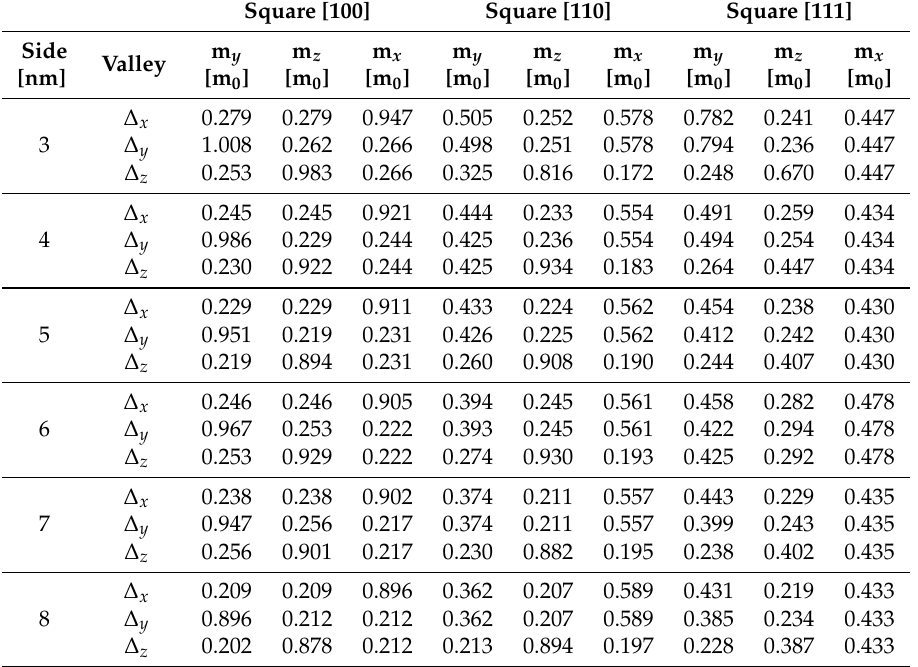
Table 1. Effective masses for square nanowire.